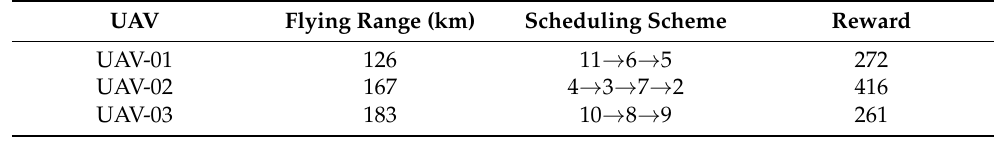
Table 10. Task Re-scheduling Schemes based on Replacement Contract to Deal with Emergency Tasks.